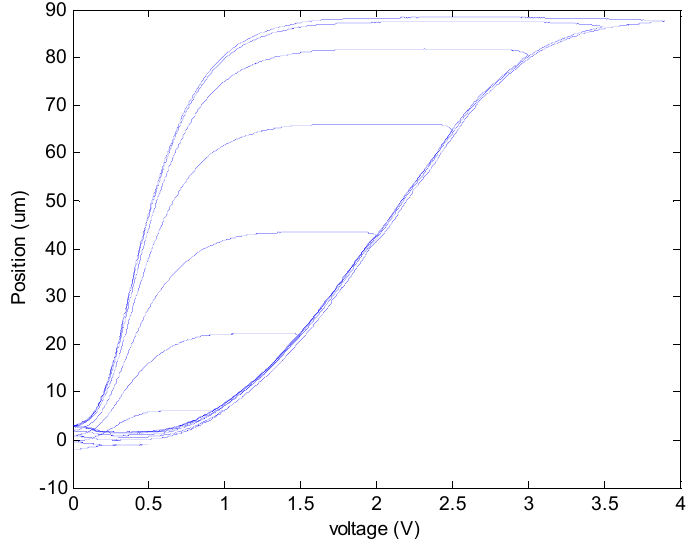
Figure 3. Hysteresis phenomenon of the MSM actuator. Triangle wave voltages range from 0 V to 4 V. After each experiment, subtract 0.5 V each time from the previous voltage until the highest voltage reaches 0.5 V.